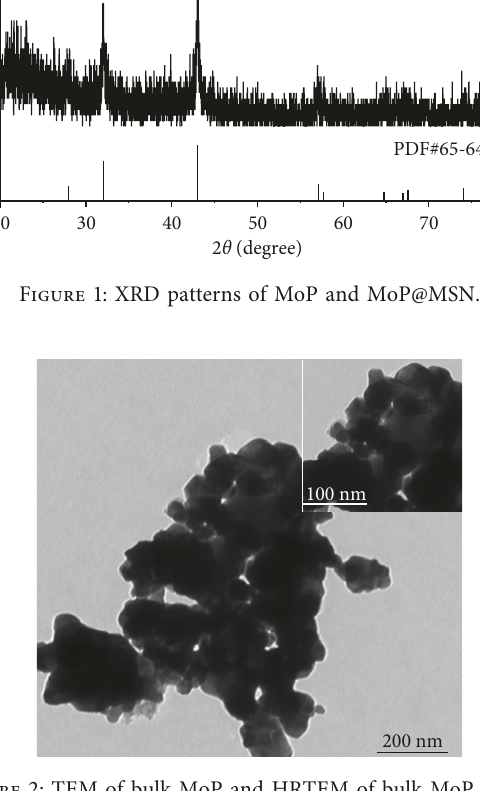
Figure 2: TEM of bulk MoP and HRTEM of bulk MoP